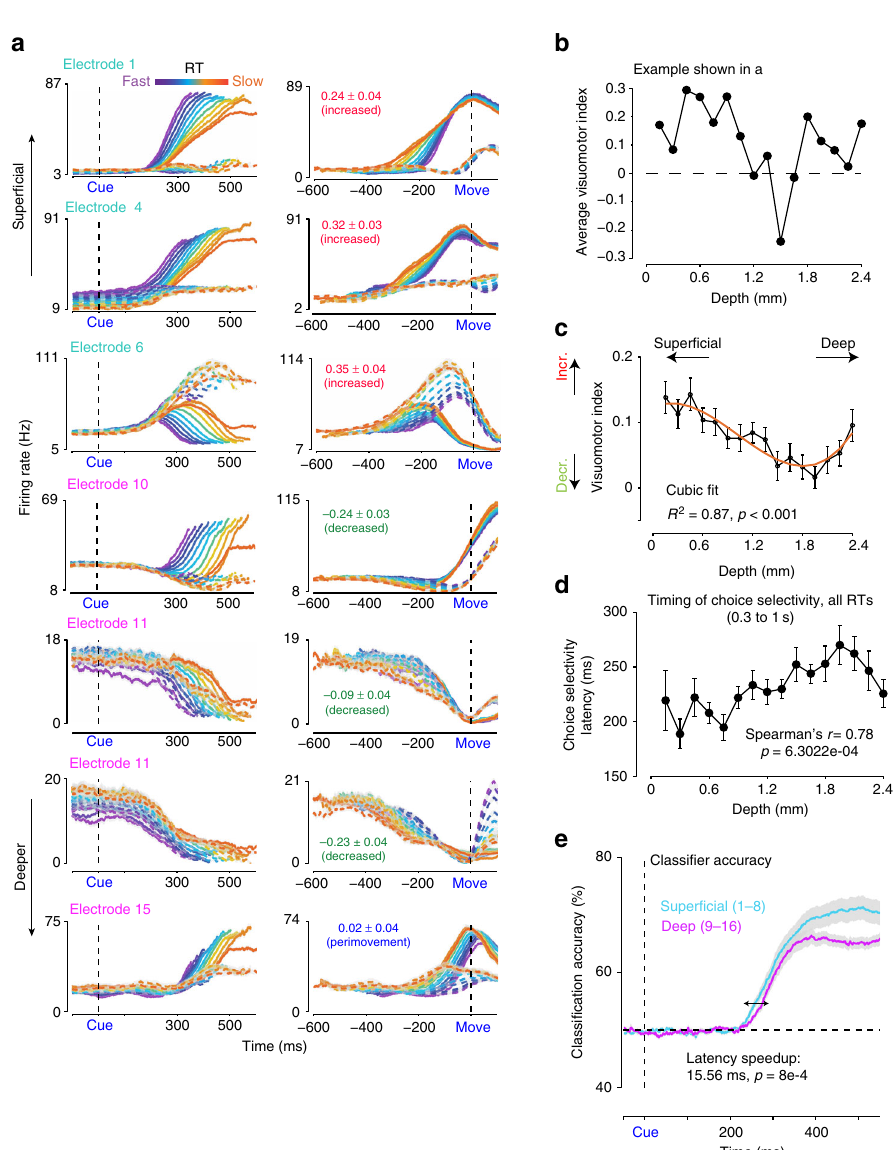
Fig. 4 Laminar differences in the time course of decision-related signals in PMd. a PSTHs from seven different units recorded in the same session sorted as a function of RT and choice and ordered from super fi cial to deep electrodes. The FRs are aligned relative to checkerboard cue onset ( left ) or to movement onset ( right ). The colors ranging from purple to orange depict different RT bins. Shaded errors denote SEM. Solid lines depict left reaches and dashed lines depict right reaches. Peristimulus and perimovement FRs are estimated by convolving spike trains with 75 ms causal boxcars. Averages include all trials sorted according to the choice of the monkey (left vs. right). Also shown for each unit is the visuomotor index estimated for the unit along with con fi dence intervals and the label associated with the unit based on the visuomotor index. The rough pattern that this single example and a similar example shown in Supplementary Fig. 11 is that super fi cial electrodes have positive indices denoting increased units whereas the deeper electrodes are likely to have more perimovement and decreased units. X -axes depict time in ms. Y -axes depict FR in Hz. PSTHs and PMTHs re fl ect FR averaged over more than 100 trials per condition. > 1800 trials were analyzed for these units. These trials were then separated according to the condition. b Visuomotor index as a function of cortical depth for the session shown in Fig. 4a. X -axes depict depth in mm. Y -axes depict the index. Error bars denote SEM. Visuomotor index for each electrode is estimated by averaging over all units recorded on that particular channel. c The visuomotor index estimated by pooling over sessions from both monkeys T and O decreases as a function of depth (68 sessions, 554 units). X -axes depict depth in mm. Y -axes depict the index. Error bars denote SEM. The line (shown in orange ) is the fi t of this average index vs. cortical depth using a cubic function ( ax 3 + bx 2 + cx + d ). x is a variable denoting cortical depth. Reported p -value for the fi t is obtained by a permutation test where we shuf fl ed to remove the relationship between the index and cortical depth and computed the fi t. We repeated this shuf fl ing 1000 times and fi t the cubic function to estimate a surrogate distribution of R 2 values. A simple linear regression was also signi fi cant ( R 2 = 0.61, p < .001). We chose higher order fi ts because of the non-monotonic nature of the change in the index as a function of cortical depth. d Average choice selectivity as a function of cortical depth for the population of PMd neurons. X -axis depicts depth in mm. Y -axis the discrimination latency in ms. Error bars denote SEM estimated over sessions. e Classi fi er accuracy for super fi cial (electrodes 1 – 8) and deep (9 – 16) as a function of time for all RTs when aligned to checkerboard cue onset. The classi fi cation was performed on a session-by-session basis, and the number of units used for super fi cial and deep electrodes were equalized by setting the number of units used for the super fi cial and deep classi fi ers to be the same. We only used sessions where we had greater than 10 units recorded from the U-probes in this classi fi cation analysis. We used 50 ms bins stepped by 2 ms bins and used a linear classi fi er NATURE COMMUNICATIONS | 8: 614 | DOI: 10.1038/s41467-017-00715-0 |